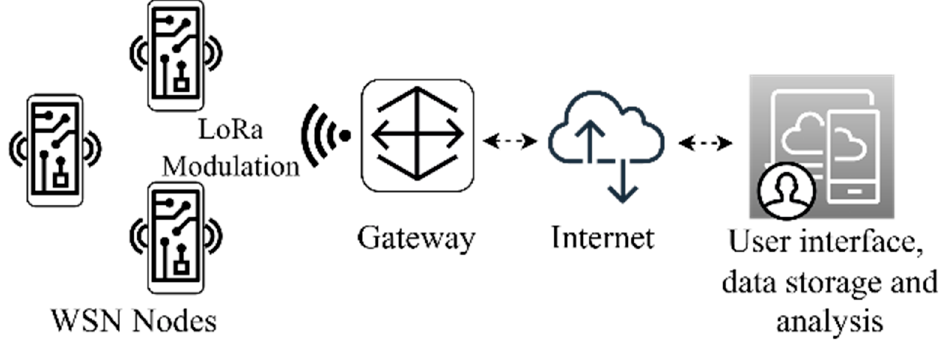
Figure 1. LoRaWAN IoT network general architecture.